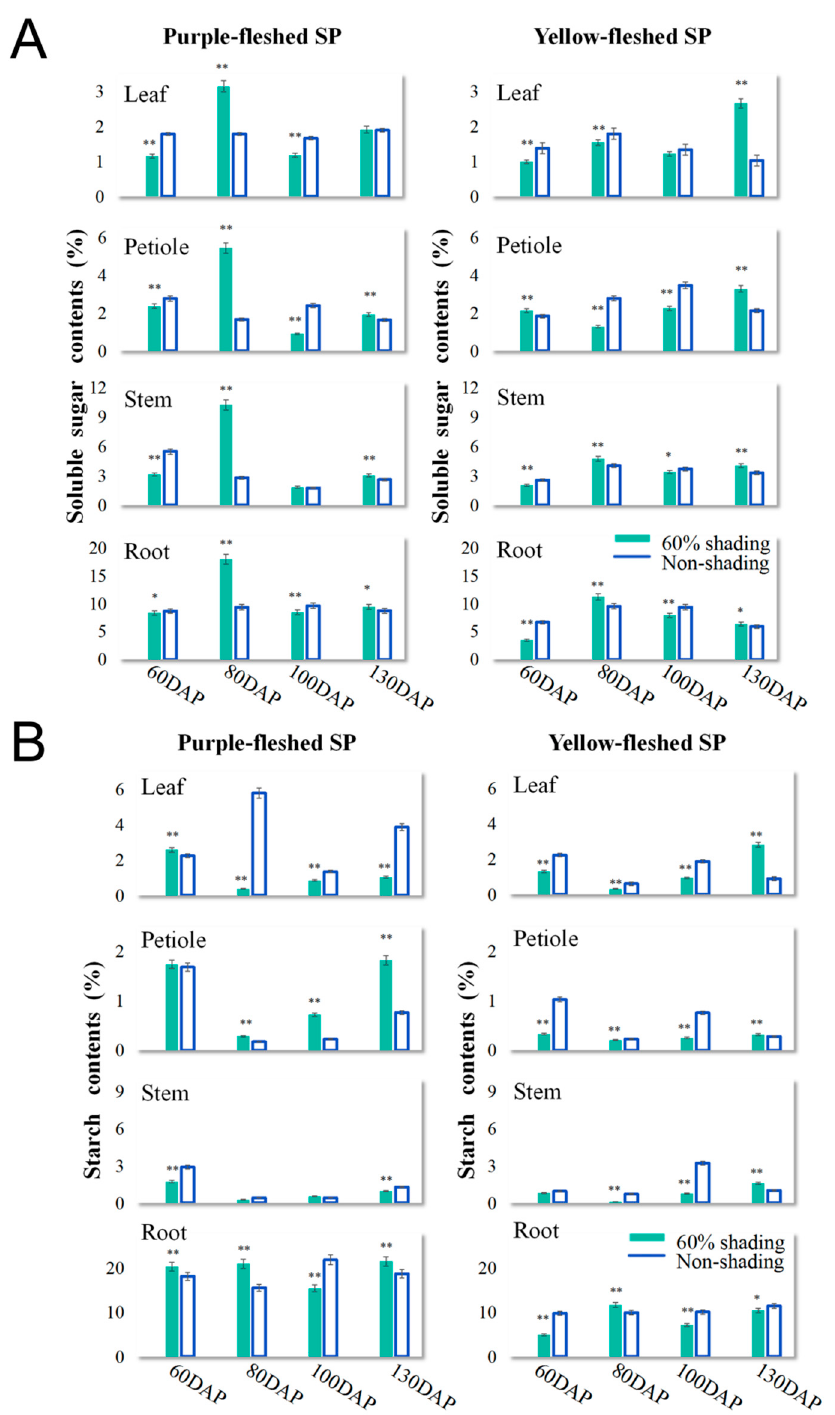
Figure 2. The contents of soluble sugar and starch in sweet potato during storage root development under shaded conditions. The contents of soluble sugar ( A ) and starch ( B ) from SP different tissues under 60% shading and non-shading treatment at 60–130 DAP. Data represent the mean ± s.d. (n = 3, three individual biological samples). The asterisks represent significant differences between those data under 60% shading and non-shading treatment by Student’s t -test at p < 0.05 ( * ) and p < 0.01 (**), respectively. Days after planting, DAP; sweet potato, SP.